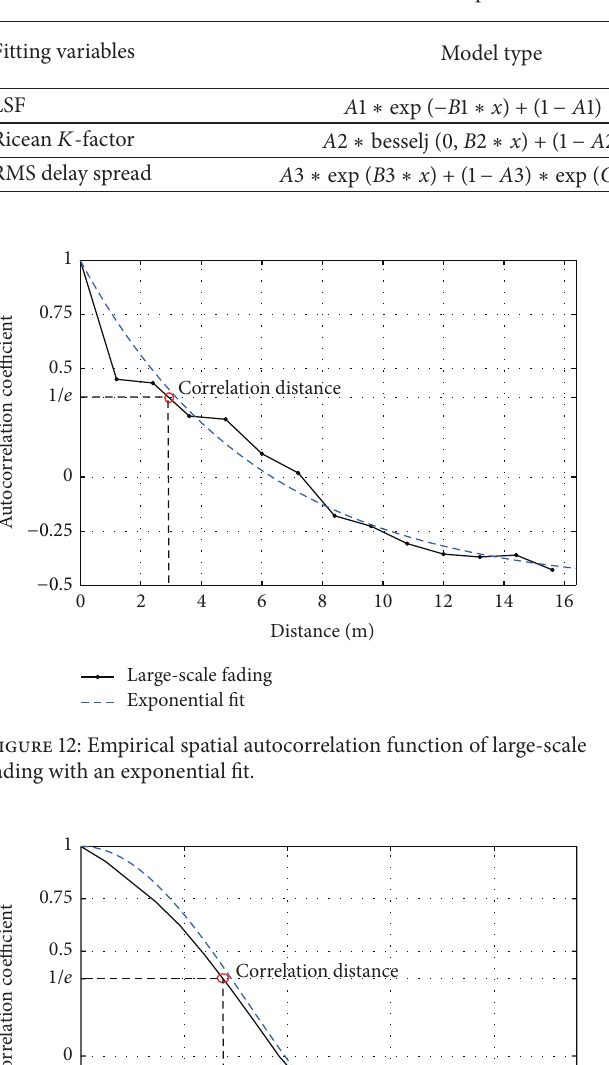
Table 4: Spatial autocorrelation fitting parameters.